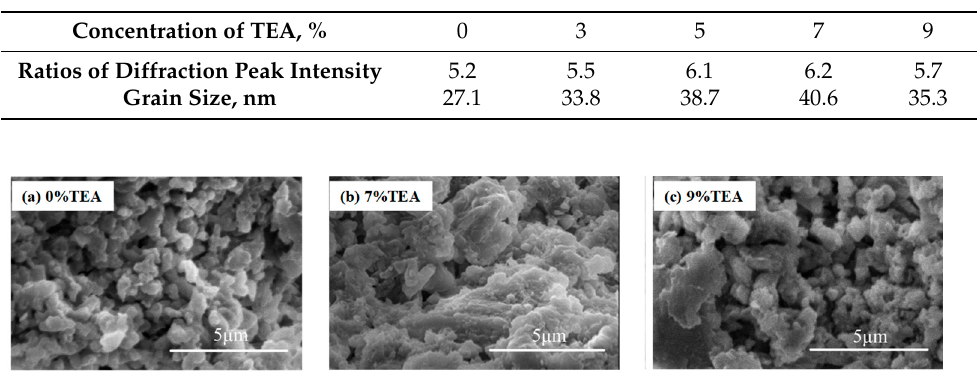
Table 1. Ratios of diffraction peak intensity of crystal plane from (104) to (113) and grain size of calcite.